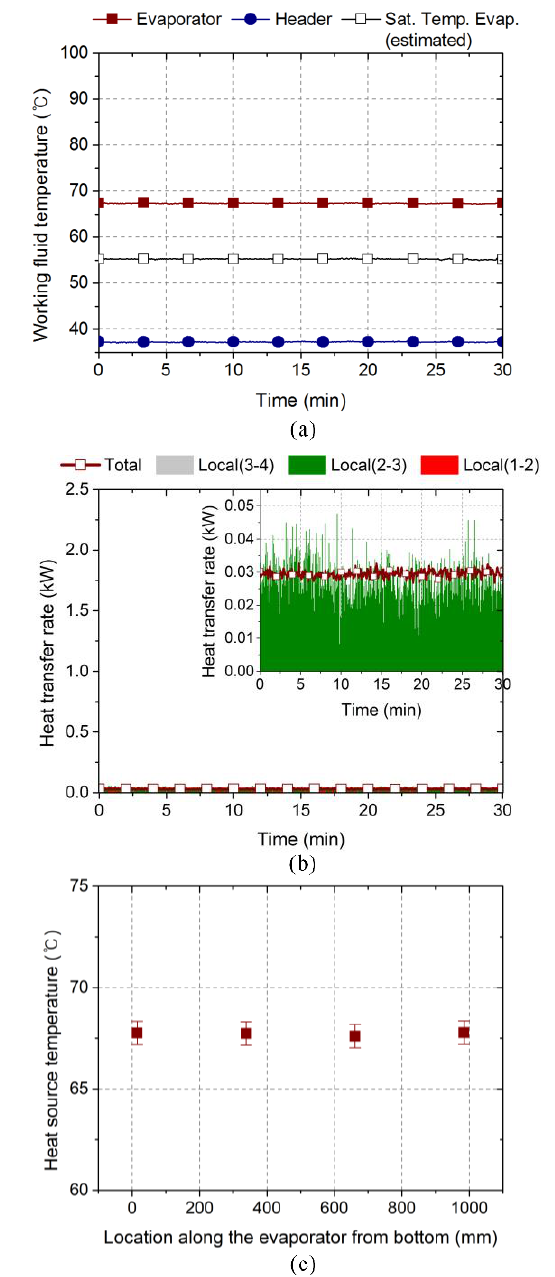
Figure 13. Operating characteristics of the FHP with a heat source temperature of 67.3 °C: ( a ) working fluid temperature, ( b ) cumulative heat transfer rate, and ( c ) local heat source temperature.